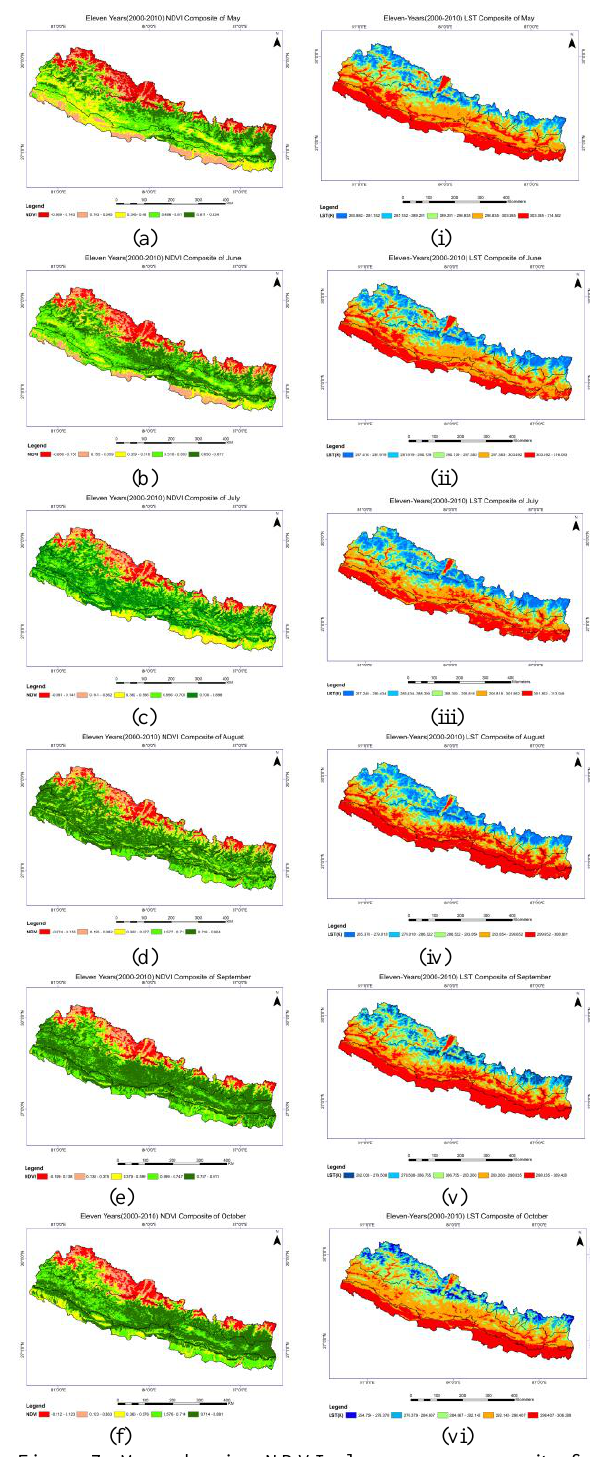
Figure 7. Map showing NDVI eleven-years composite for (a).May, (b).June, (c).July, (d).August, (e).September and (f).October and map showing temperature eleven-years composite for (i).May, (ii).June, (iii).July, (iv).August, (v).September and